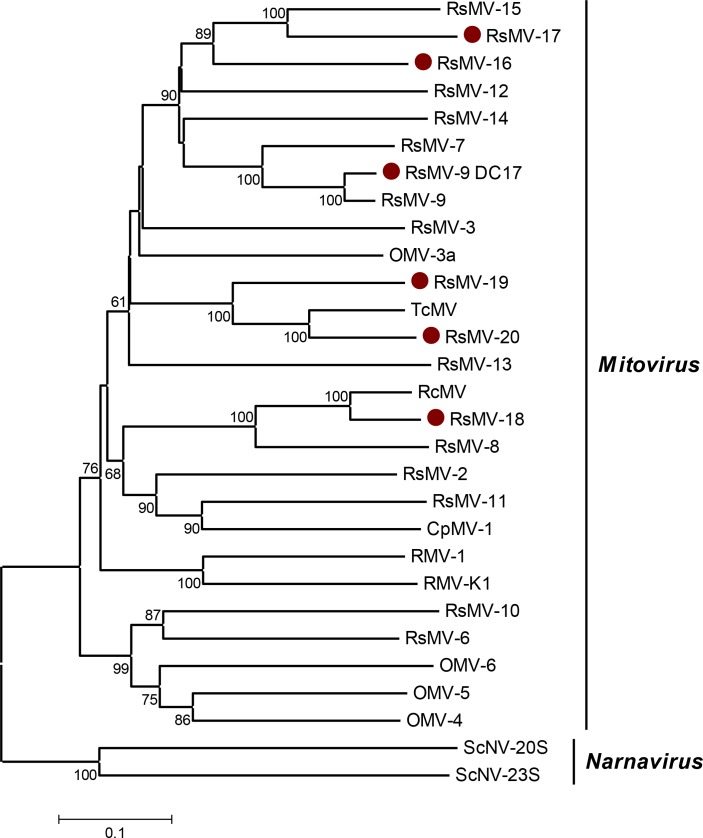
Phylogenetic analysis of the members of the family Narnaviridae.An unrooted phylogenetic tree of the Narnaviridae was calculated based on the alignment of the RdRp domain spanning the conserved motifs A to F using the neighbor-joining method with 1000 bootstrap replicates. The scale represents a genetic distance of 0.1 amino acid substitutions per site. Bootstrap values < 50% are not shown. Analyzed species include mitoviruses identified in Rhizoctonia as well as species of the family Narnaviridae recognized by the ICTV. Species identified in this study are marked with dots. Analysis was conducted using MEGA 6.06 and the sequence alignment algorithm MUSCLE [45]. CpMV-1, Cryphonectria parasitica mitovirus (NP_660174.1); OMV-3a, Ophiostoma mitovirus 3a (CAJ32468.1); OMV-4, Ophiostoma mitovirus 4 (NP_660179.1); OMV-5, Ophiostoma mitovirus 5 (NP_660180.1); OMV-6, Ophiostoma mitovirus 6 (NP_660181.1); ScNV-20S, Saccharomyces 20S RNA narnavirus (NP_660178.1); ScNV-23S, Saccharomyces 23S RNA narnavirus (NP_660177.1); RsMV-1, Rhizoctonia solani mitovirus 1 (ALD89121.1); TcMV-1, Thanatephorus cucumeris mitovirus 1 (AAD17381.1); RsMV-2, Rhizoctonia solani mitovirus 2 (ALD89121.1); RsMV-3, Rhizoctonia solani mitovirus 3 (ALD89122.1); RsMV-4, Rhizoctonia solani mitovirus 4 (ALD89123.1); RsMV-5, Rhizoctonia solani mitovirus 5 (ALD89124.1); RsMV-6, Rhizoctonia solani mitovirus 6 (ALD89125.1); RsMV-7, Rhizoctonia solani mitovirus 7 (ALD89126.1); RsMV-8, Rhizoctonia solani mitovirus 8 (ALD89127.1); RsMV-9, Rhizoctonia solani mitovirus 9 (ALD89128.1); RsMV-10, Rhizoctonia solani mitovirus 10 (ALD89102.1); RsMV-11, Rhizoctonia solani mitovirus 11 (ALD89116.1); RsMV-12, Rhizoctonia solani mitovirus 12 (ALD89117.1); RsMV-13, Rhizoctonia solani mitovirus 13 (ALD89118.1); RsMV-14, Rhizoctonia solani mitovirus 14 (ALD89119.1); RsMV-15, Rhizoctonia solani mitovirus 15 (ALD89120.1); RsMV-K1, Rhizoctonia solani mitovirus K1 (ALD60243.1); RcMV, Rhizoctonia cerealis mitovirus (AIT71973.1); RsMV-9, Rhizoctonia solani mitovirus 9 DC17 (KX349058); RsMV-16, Rhizoctonia solani mitovirus 16 (KX349057); RsMV-17, Rhizoctonia solani mitovirus 17 (KX349059); RsMV-18, Rhizoctonia solani mitovirus 18 (KX349060); RsMV-19, Rhizoctonia solani mitovirus 19 (KX349056); RsMV-20, Rhizoctonia solani mitovirus 20 (KX349062).